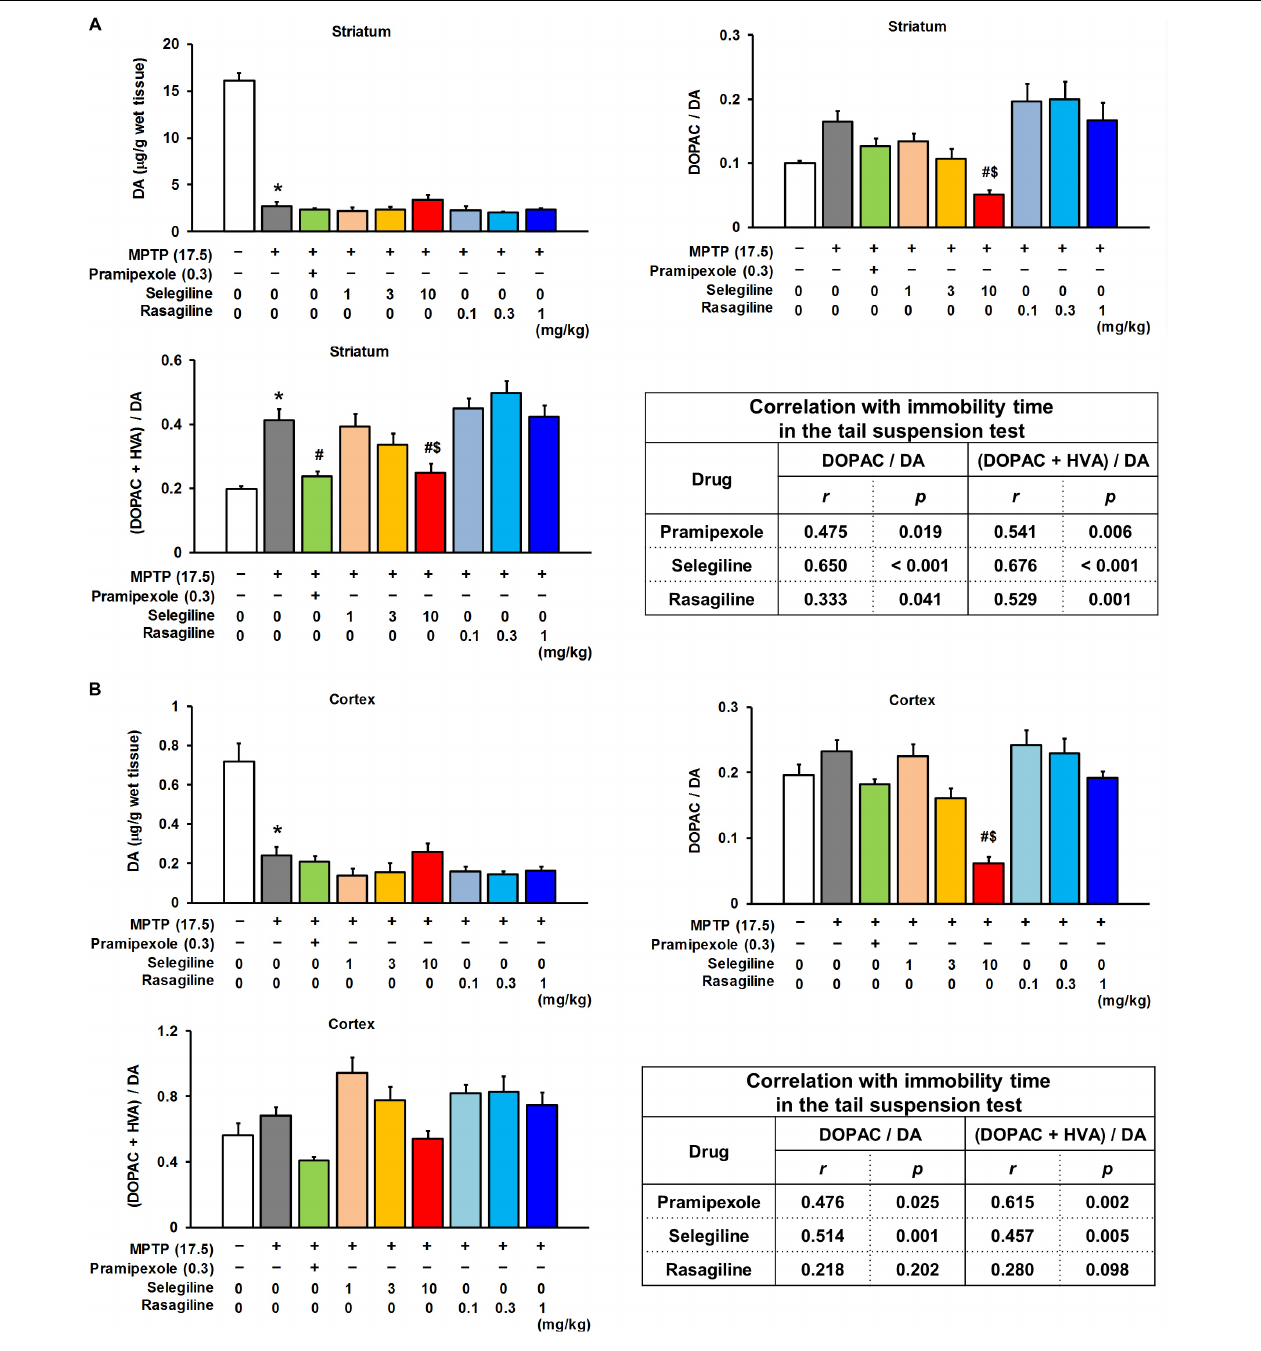
FIGURE 3 | Effects of selegiline (SEL), rasagiline (RAS), and pramipexole (PRX) on dopamine (DA) content and its turnover rate in the striatum and cortex of MPTP mice. (A) Effects of SEL, RAS, and PRX on DA content and its turnover rate in the striatum. The groups were control ( n = 8), MPTP + saline ( n = 8), MPTP + PRX ( n = 8), MPTP + 1 mg/kg SEL ( n = 7), MPTP + 3 mg/kg SEL ( n = 7), MPTP + 10 mg/kg SEL ( n = 8), MPTP + 0.1 mg/kg RAS ( n = 7), MPTP + 0.3 mg/kg RAS ( n = 7), and MPTP + 1 mg/kg RAS ( n = 8). Values represent means ± SEM. ∗ p < 0.05 versus the control group. # p < 0.05 versus the MPTP + saline group. $ p < 0.05 versus the MPTP + 1 mg/kg RAS group {DA content and 3,4-dihydroxyphenylacetic acid (DOPAC)/DA: Games–Howell test [DOPAC + homovanillic acid (HVA)]/DA: Tukey’s test}, DA content: F ( 8 , 59 ) = 107.131, p < 0.05; DOPAC/DA: F ( 8 , 59 ) = 6.877, p < 0.05; (DOPAC + HVA)/DA: F ( 8 , 59 ) = 10.808, p < 0.05. (B) Effects of SEL, RAS, and PRX on DA content and its turnover rate in the cortex. The groups were control ( n = 8), MPTP + saline ( n = 6), MPTP + PRX ( n = 8), MPTP + 1 mg/kg SEL ( n = 7), MPTP + 3 mg/kg SEL ( n = 7), MPTP + 10 mg/kg SEL ( n = 8), MPTP + 0.1 mg/kg RAS ( n = 7), MPTP + 0.3 mg/kg RAS ( n = 7), and MPTP + 1 mg/kg RAS ( n = 8). Values represent means ± SEM. # p < 0.05 versus the MPTP + saline group. $ p < 0.05 versus the MPTP + 1 mg/kg RAS group (DA content: Games–Howell test; DA turnover: Tukey’s test), DA content: F ( 8 , 57 ) = 16.249, p < 0.05; DOPAC/DA: F ( 8 , 57 ) = 12.061, p < 0.05; (DOPAC + HVA)/DA: F ( 8 , 57 ) = 5.767, p < 0.05.